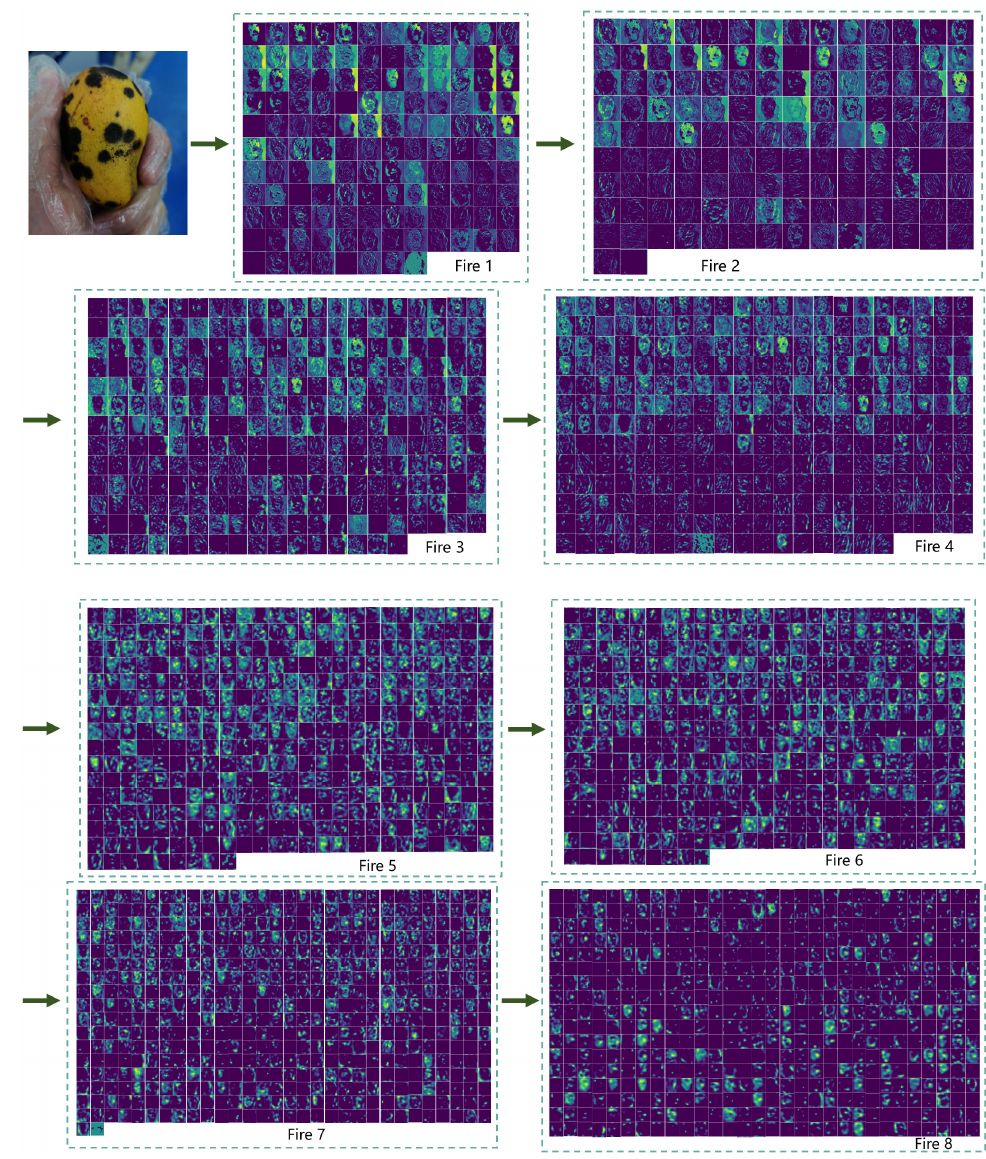
Figure 6. Visualization results of convolution-layer features.